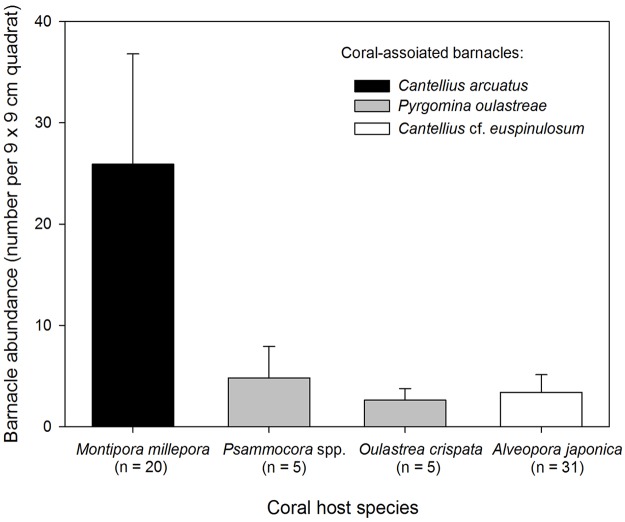
Mean abundance (+1 standard deviation) of coral-associated barnacles Cantellius arcuatus, C. cf. euspinulosum and Pyrgomina oulastreae on their coral hosts Montipora millepora, Psammocora spp., Osulastrea crispata and Alveopora japonica, respectively, in Jeju Island.Psammocora spp. include both P. profundacella and P. albopicta.